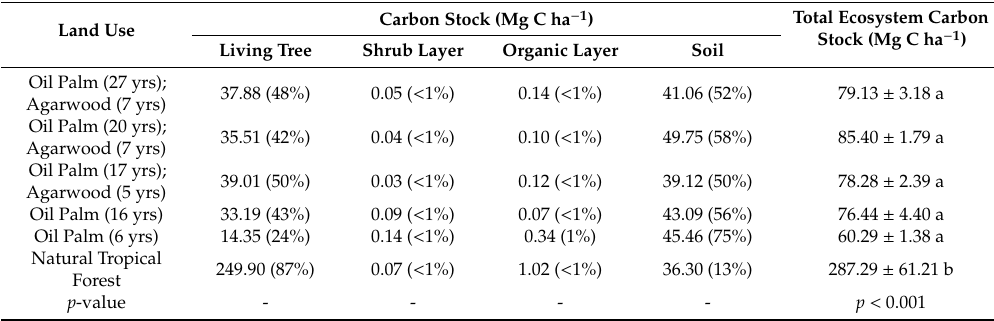
Table 4. Total ecosystem carbon stock in di ff erent land